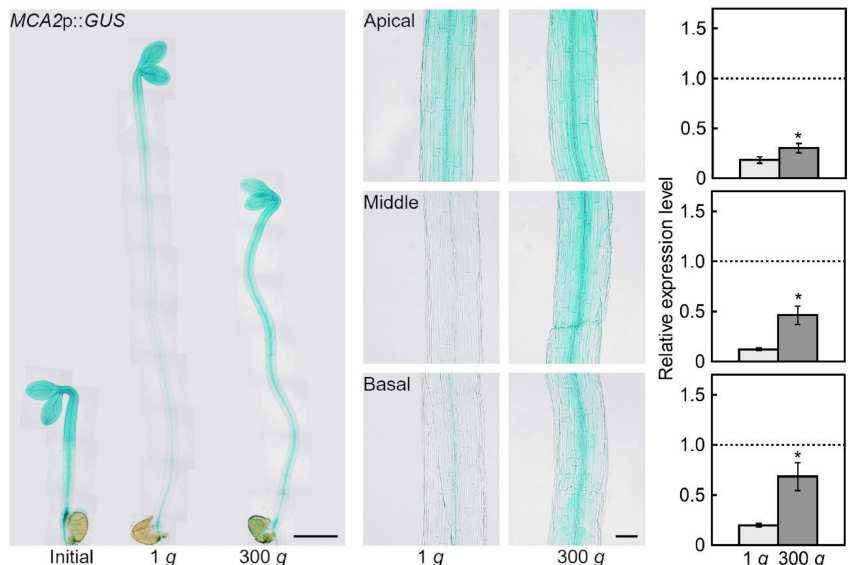
Figure 2. E ff ects of hypergravity on MCA2 gene expression. An MCA2 p:: GUS transgenic line was grown as described in Figure 1. Left, GUS-stained seedlings (bar = 1 mm). Middle, magnification of the hypocotyls (bar = 0.1 mm). Right, quantified GUS-staining intensity (expression level) of each region of the hypocotyl. The expression level was normalized to the initial mean value. The dashed line indicates the initial values. Values are means ± SE ( n = 10–12). * Mean value with a significant di ff erence between the 1 g and 300 g treatments (Student’s t- test: P <